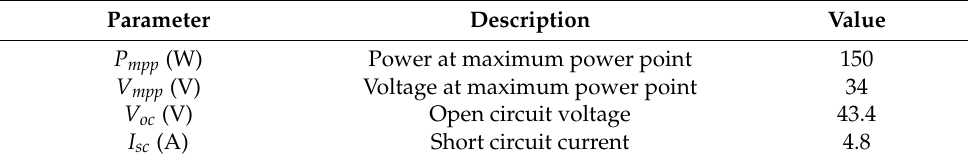
Figure 1. The residential nanogrid considered in the study. Table 1. Electrical characteristics of Shell SP150-P module at standard test conditions (STC). Parameter Description